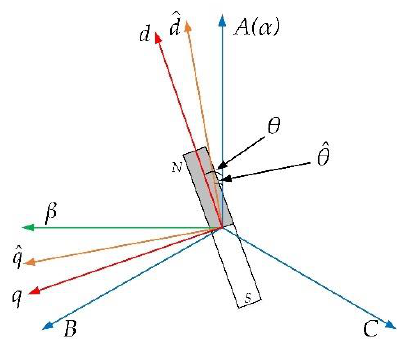
Figure 1. Coordinate system of PMSM.